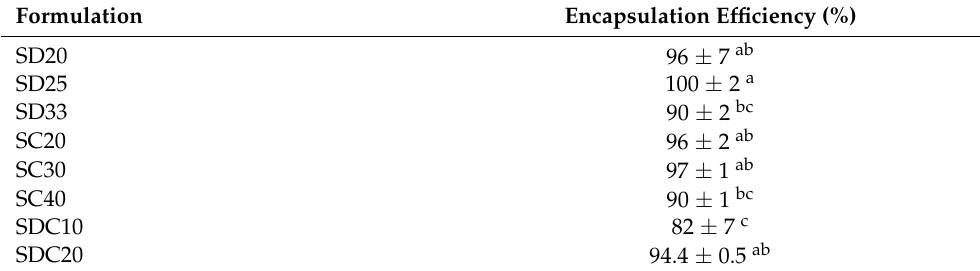
Table 3. Encapsulation efficiency (%) of microparticles obtained by spray drying, chilling, and their